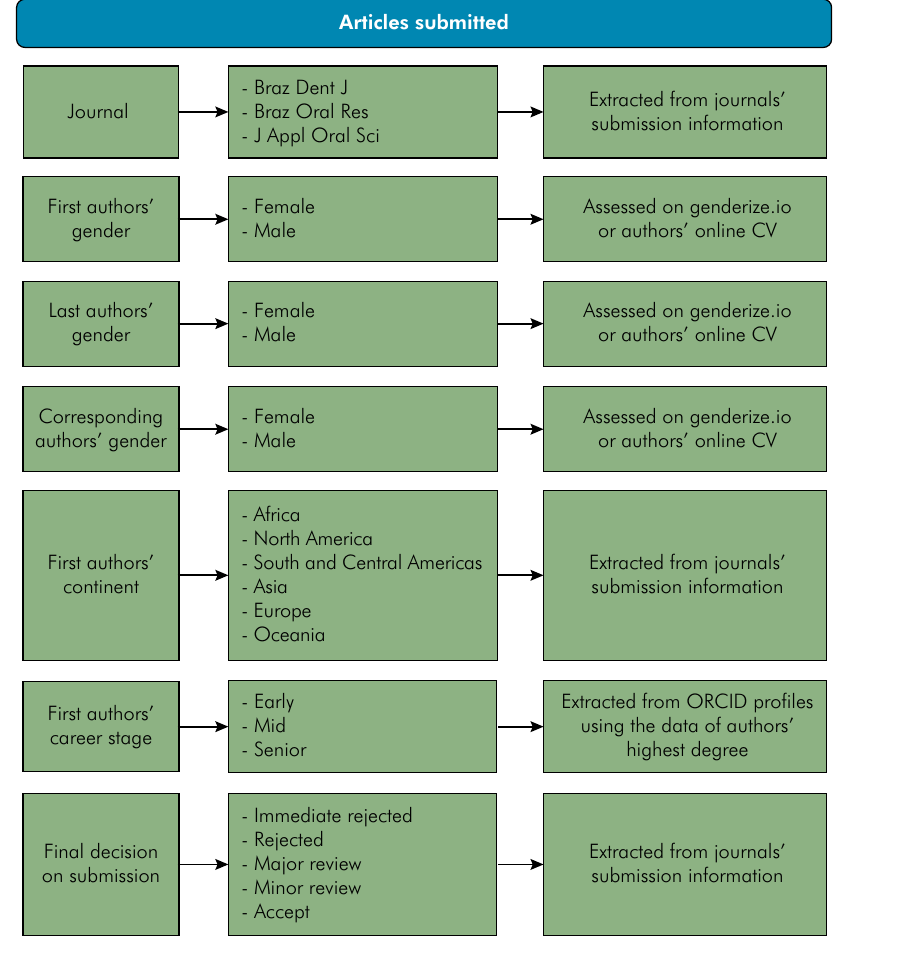
Figure 1. Diagram of data extraction and sources of